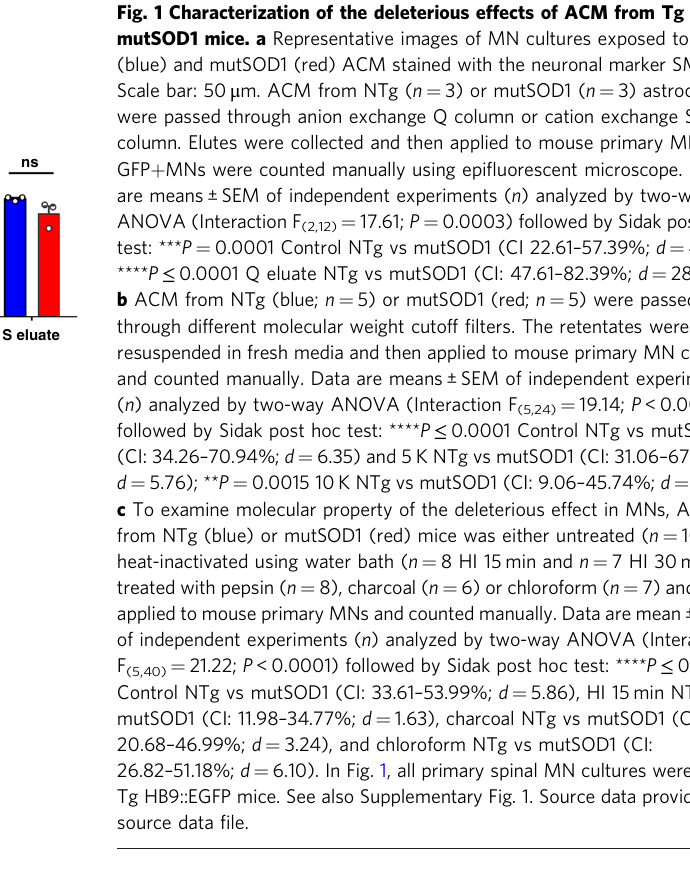
Fig. 1 Characterization of the deleterious effects of ACM from Tg mutSOD1 mice. a Representative images of MN cultures exposed to NTg (blue) and mutSOD1 (red) ACM stained with the neuronal marker SMI-32. Scale bar: 50 μ m. ACM from NTg ( n = 3) or mutSOD1 ( n = 3) astrocytes were passed through anion exchange Q column or cation exchange S column. Elutes were collected and then applied to mouse primary MNs.